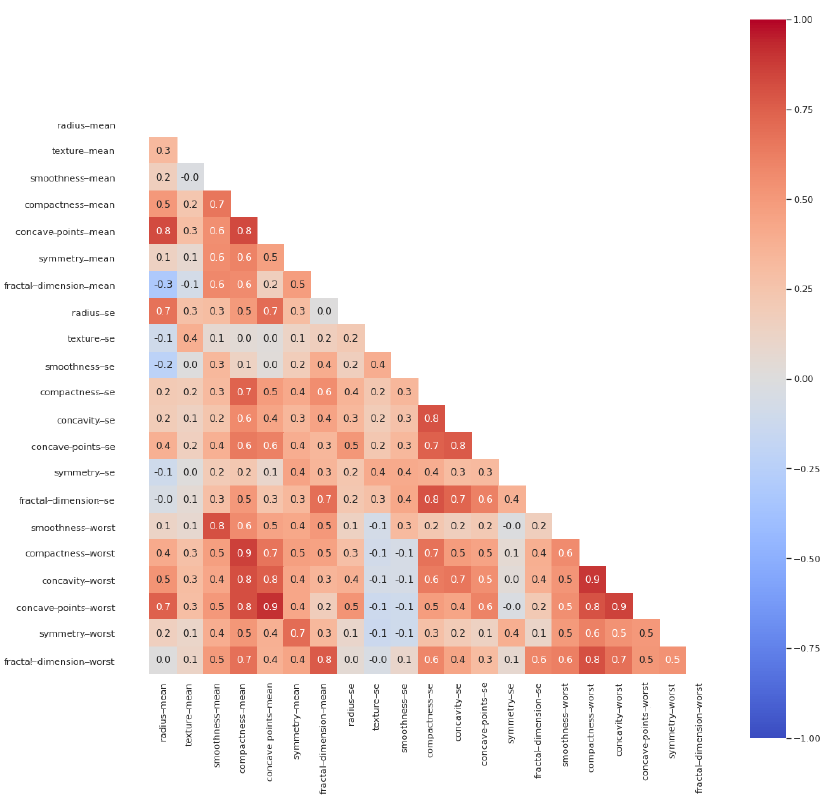
Figure 3. Heat map plot showing the correlations among selected features of WBCD dataset.